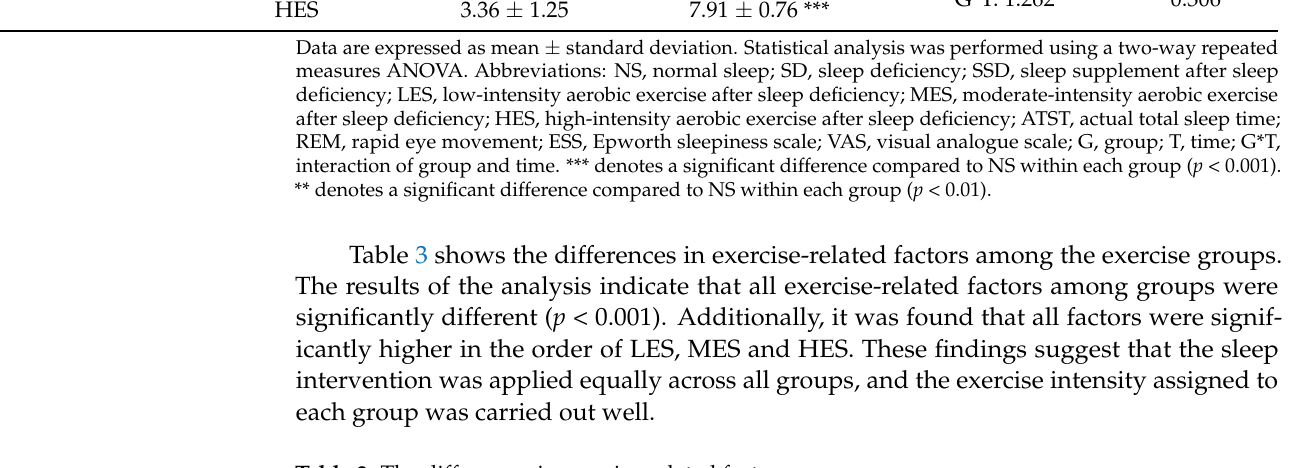
Table 3. The differences in exercise-related factors among